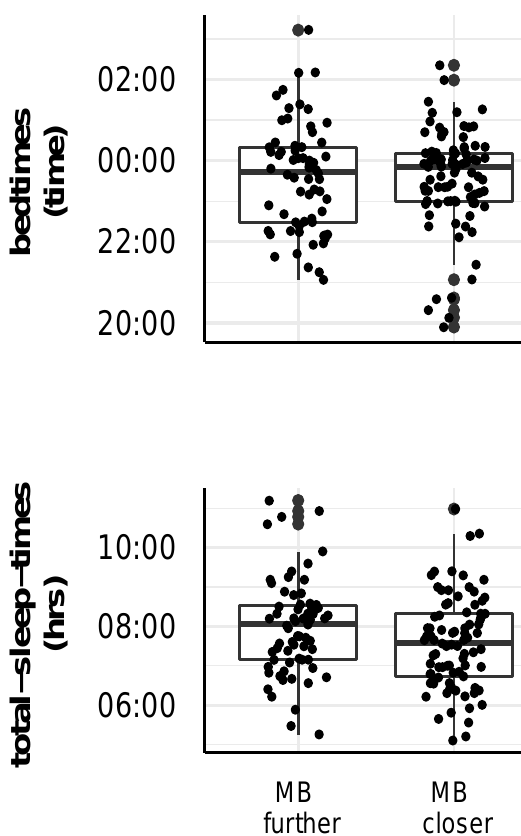
Figure A2. Impact of actigraphy wrist position (further vs. closer to the wrist) on the MB (A) and GT3X (B) sleep measures (top: wake-up-times, middle: bedtimes, bottom: total-sleep-times). The limits of the boxplots represent the 95% CI, while the horizontal middle line represents the